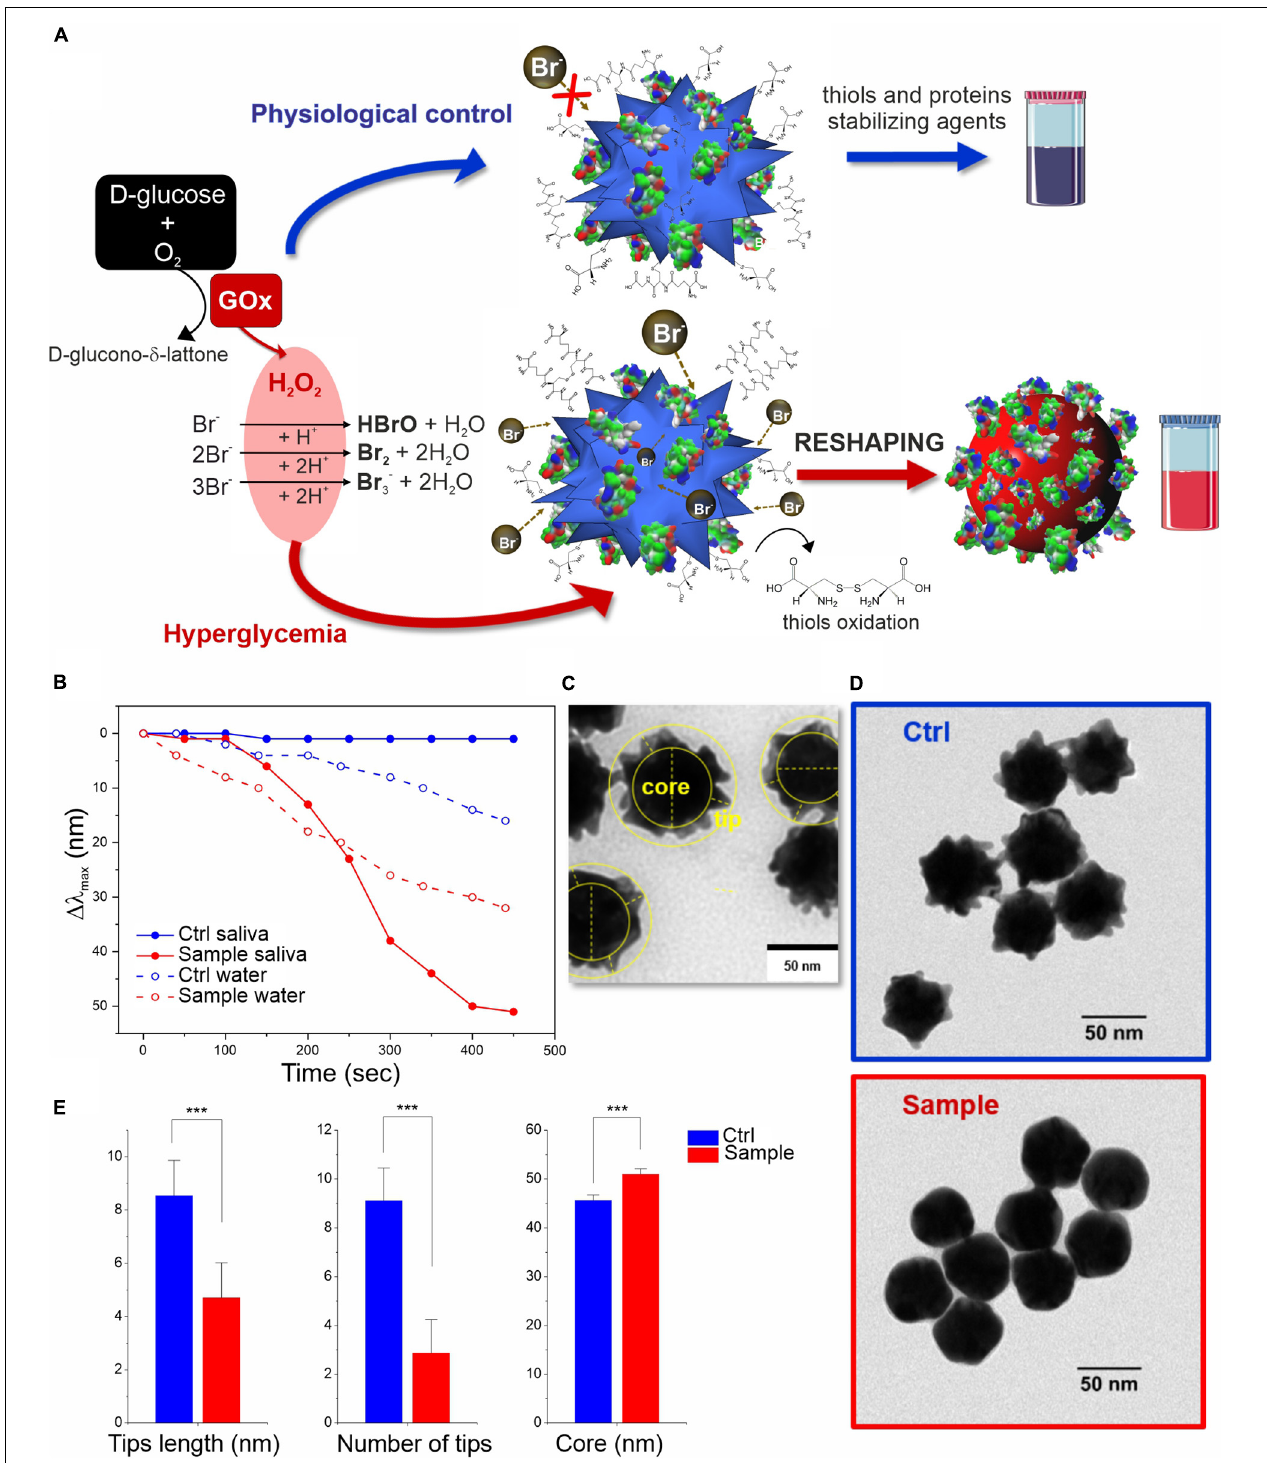
FIGURE 2 | In vitro colorimetric assay using MGNPs suspended in saliva: (A) schematics of the mechanisms involved; (B) LSPR (cid:49) λ max evolution over time related to the reshaping in saliva and in water (the two model platforms performance are compared at their own Br − optimized conditions while involving the same particles number, and H 2 O 2 final concentration, 2 mM). TEM micrographs related to the MGNPs before (C) and after (D) the assay with non-supplemented saliva (blue) and with glucose supplement to simulate hyperglycemia condition (red). (E) Statistical TEM analysis measuring tips (numbers and lengths) and “core” dimensional variation between control and sample nanostructures ( p < 0.001 in all cases). Statistical significance was determined by Mann-Whitney test (*** p < 0.001). See experimental details in Supplementary Material.